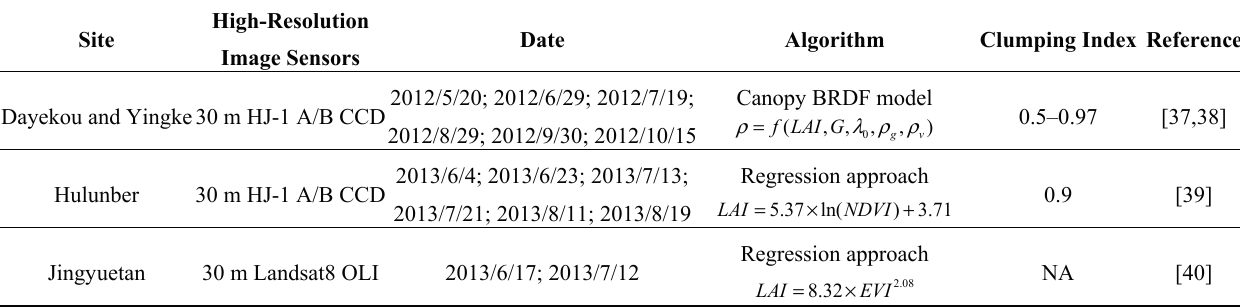
Table 2. Characteristics of the LAI reference maps of the validation sites (In the BRDF equation, ρ represents the canopy reflectance; G is the G-function and represents the mean projection of a unit leaf area along the viewing or the illuminating directions; represents the clumping index; and background and leaf,